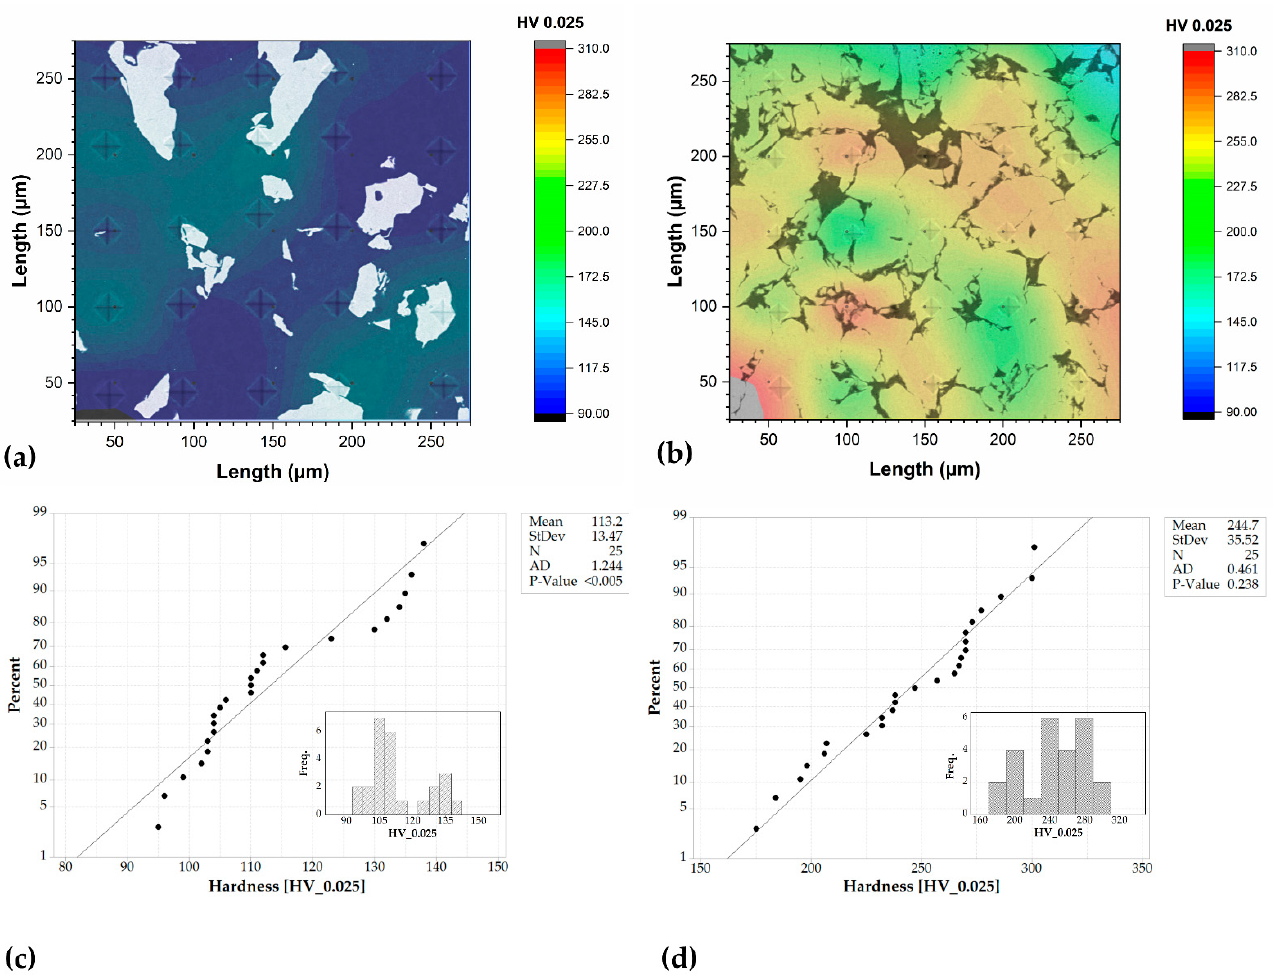
Figure 7. Microhardness mapping and statistical data distribution. ( a , c ) refer to the Ti20-AlSi composite, while ( b , d ) refer to the Ti80-AlSi composite.